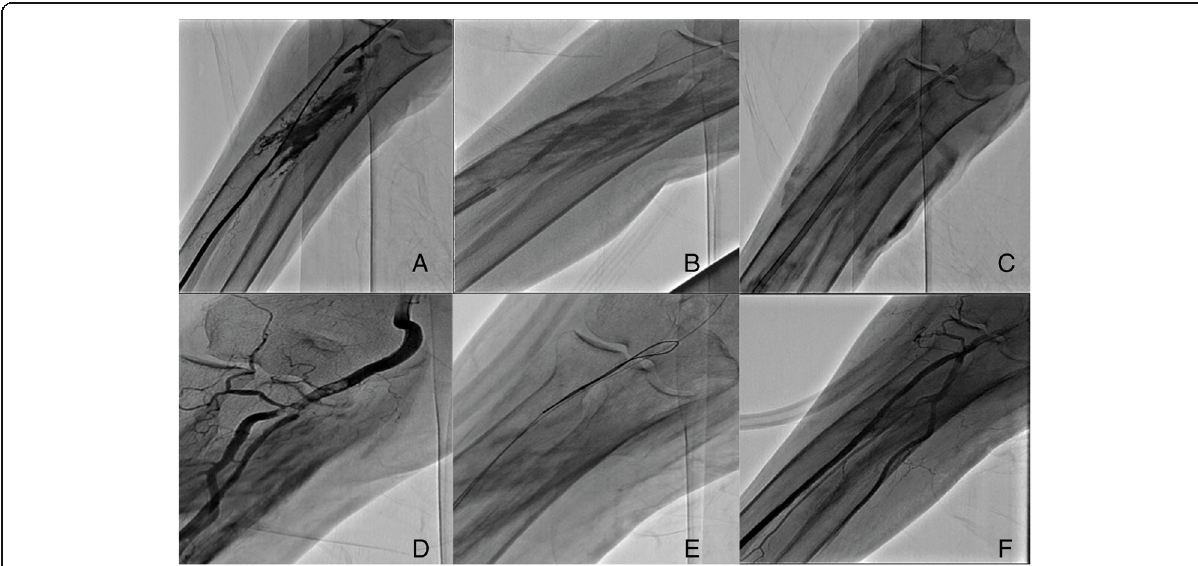
Fig. 1 a Angiogram of the radial artery showing radial artery perforation. b Prolonged balloon inflation. c A 7-F-long vascular sheath was inserted to internally tamponade the vessel. d After 4 days, angiography revealed multiple thrombi. e Successful snaring of the covered stent. f Final result after the perforation was